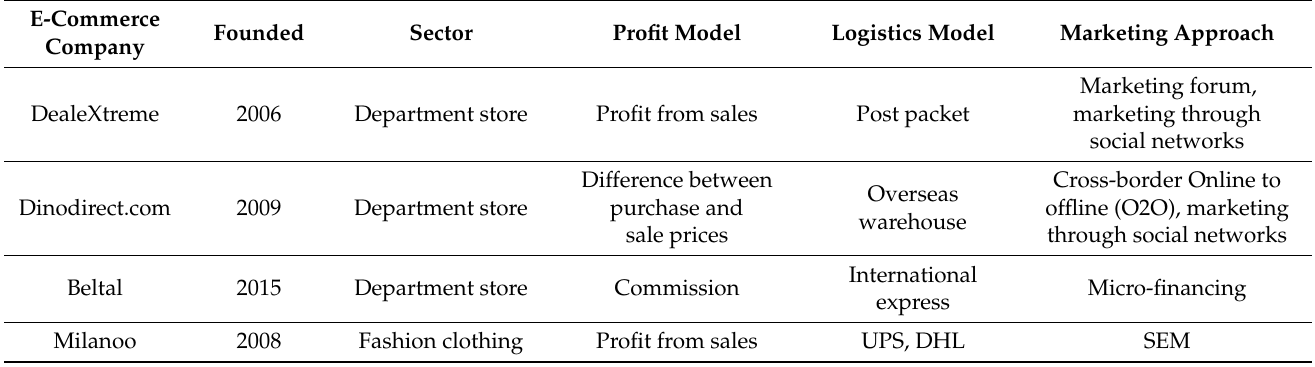
Table 4. China’s best-known companies using the business to business to consumer (B2B2C) model in cross-border